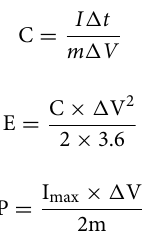
listed in Table 5. The calculations of specific capacitance (C), energy density (E), and power density (P) are based on Eqs. (4), (5), and (6), respectively 42,43 :